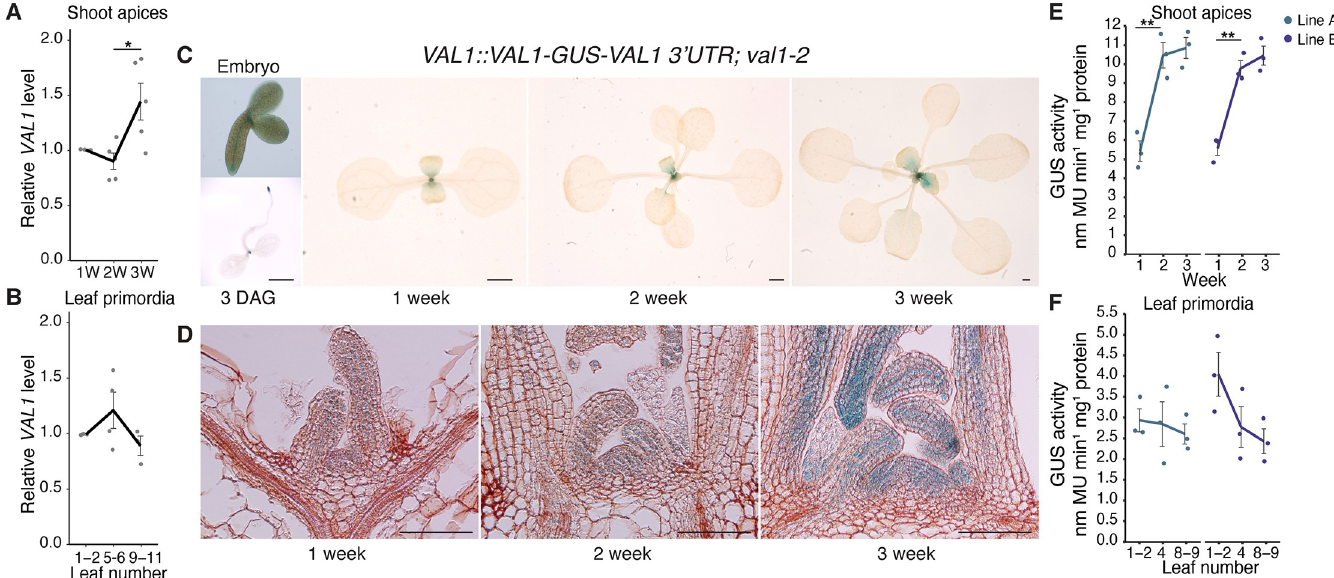
Fig 6. VAL1 is expressed throughout vegetative development. (A, B) qRT-PCR analyses of gene expression. (A) Shoot apices with leaf primordia (LP) � 1mm removed at 1, 2 and 3 weeks. (B) Isolated LP 0.5-1mm in size. (C-F) Analyses of a VAL1 - GUS translational fusion. (C) Expression in whole plants, scale bars = 1mm. (D) Expression in shoot apices following wax sectioning, scale bars = 0.1mm. (E, F) VAL1 levels quantified by MUG assay in two independent homozygous T3 lines. (A, B, E, F) Each data point represents a biological replicate and is the average of three technical replicates. Lines represent the mean and grey bars mean ± s.e.m. Asterisks represent significant differences between two continuous time points, calculated by an unpaired two-tailed t- test ( � P < 0.05; �� P < 0.01). All plants except the 3 DAG sample (C–long days) were grown in SD conditions.